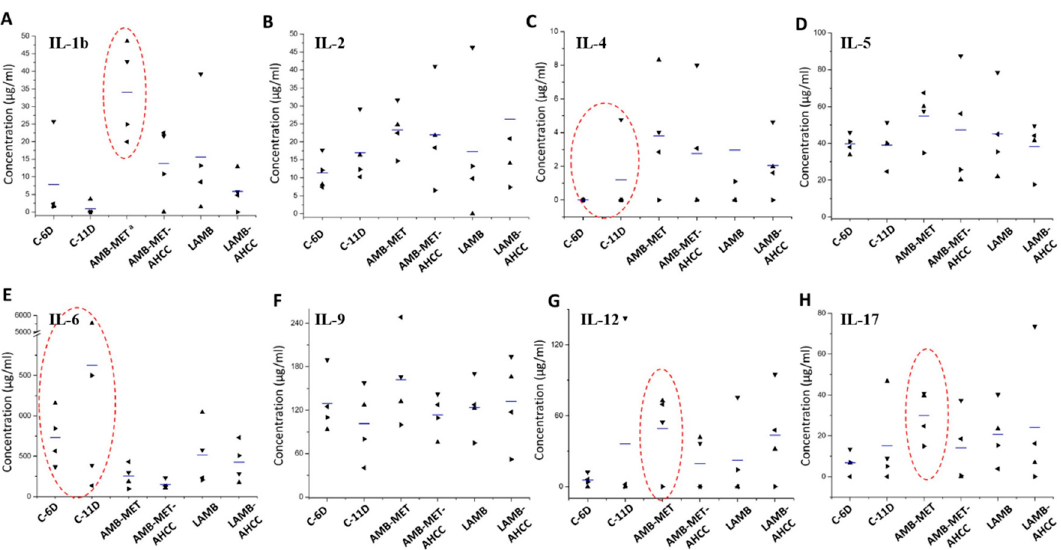
Figure 4. Scattergram of cytokine levels at day six and 11 for control group and at day 11 post-infection for all treatment groups. Key: C-6D, control group at day six post-infection, C-11D, control group at day 11 post-infection, AMB-MET, and AMB-MET-AHCC, treatment with AMB encapsulated within GCPQ nanoparticles alone or in combination with AHCC ® respectively, LAMB and LAMB-AHCC, treatment with iv liposomal AMB alone or in combination with AHCC ® respectively. Horizontal lines indicate mean values. The most relevant changes in the cytokine patterns have been highlighted within a red circle. a P < 0.05.